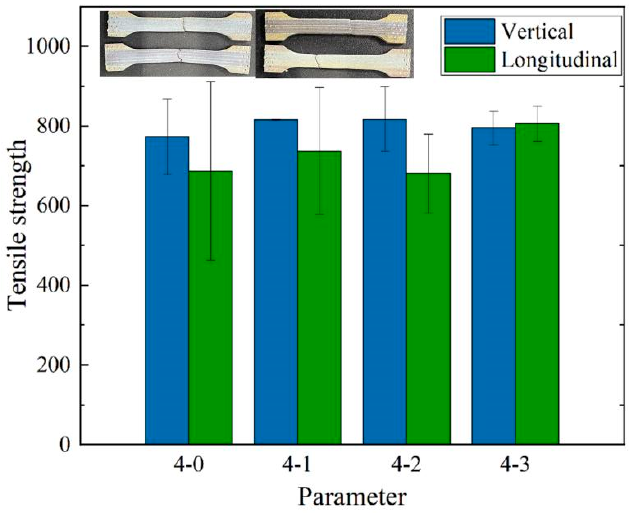
Figure 10. Tensile strength of titanium alloy thin-walled additive manufacturing component.